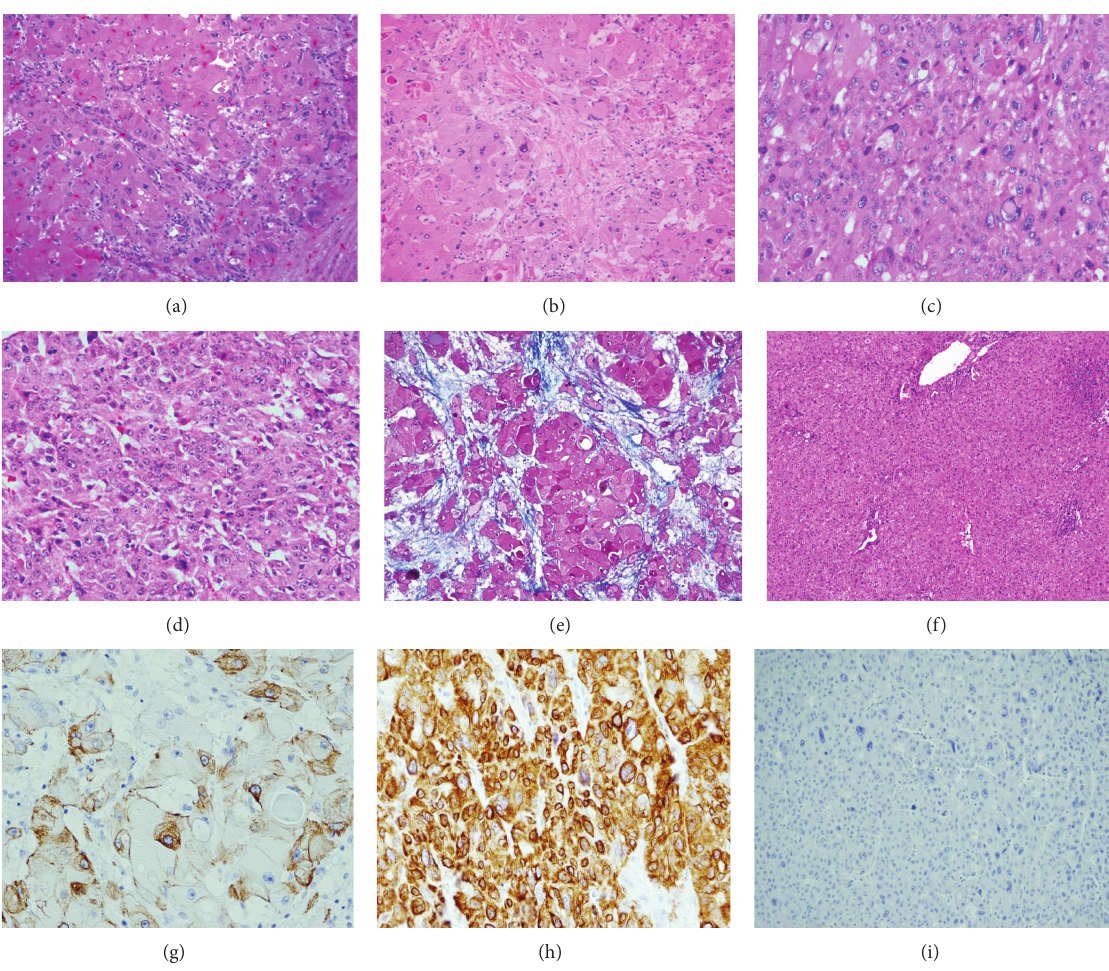
Figure 2: (a) (H and E stain, 200x) Mixed tumor composed of two different components, one with large, polygonal cells with eosinophilic cytoplasm, consistent with FLC (top left). Adjacent to it without transition (bottom right), the second component shows a neoplastic proliferation of hepatocytes with high N: C ratio and a trabecular pattern compatible with classical HCC. (b) (H and E stain, 200x) typical abundant lamellar connective tissue characterizing FLC. (c) (H and E stain, 400x) High power view of FLC component showing large neoplastic cells with abundant eosinophilic cytoplasm and pale bodies. (d) (H and E stain, 200x) Photograph of classical HCC showing nests of neoplastic hepatocytes with abnormal architecture showing thick liver plates and endothelial wraping. (e) (Masson’s trichrome stain, 200x) Lamellar connective tissue in the FLC component. (f) (H and E stain, 100x) Low power view of adjacent liver parenchyma withouth fibrosis and few foci of nonspecific lymphocytic parenchymal inflammation with retained architecture. (g) (CK7-200x) Immunohistochemistry for CK7 showing positivity in FLC and (h) (CK7-400X) in the HCC. (i) (CK19-400X) Negative in